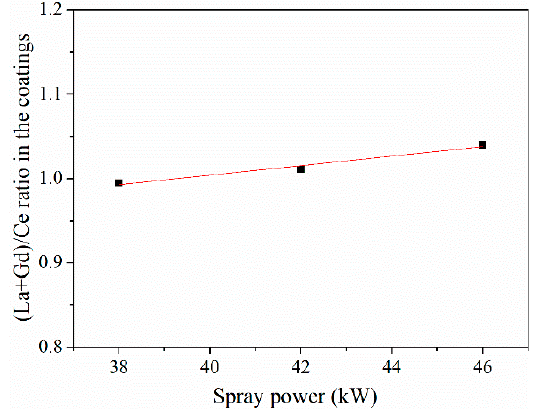
Figure 6. (La + Gd)/Ce ratio in the as-sprayed coatings versus spray power.